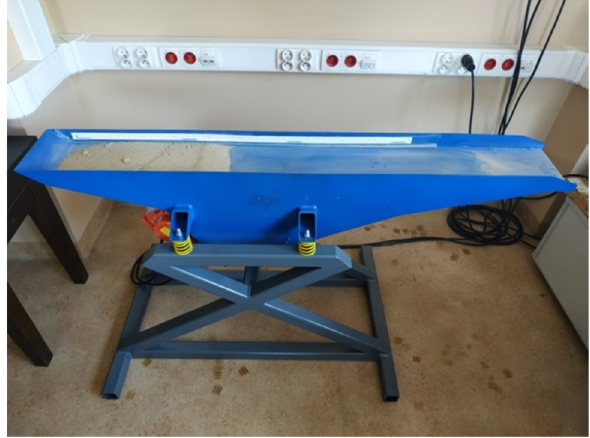
Figure 8: Prototype conveyor of the industrial scale for operations on the resonance